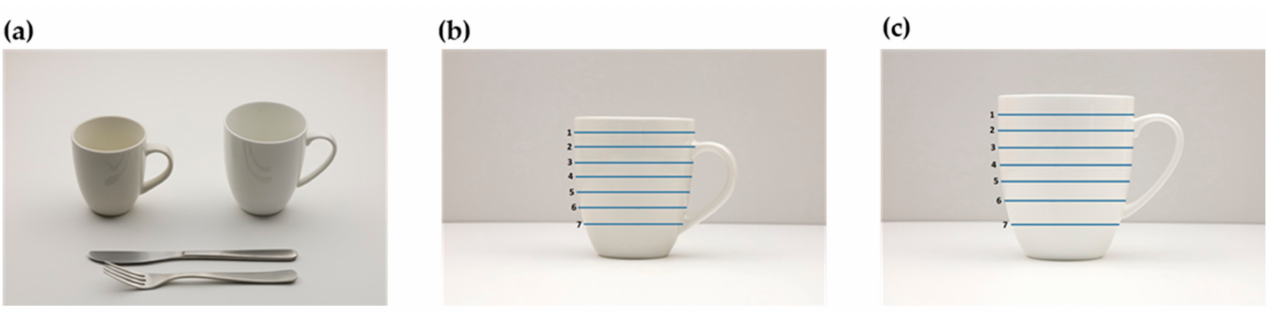
Figure 4. Examples of photographs of household measurement items. ( a ) An image to select the size of corn-shaped mugs and ( b , c ) images to select portion size of the left and right mugs, respectively, from photo ( a